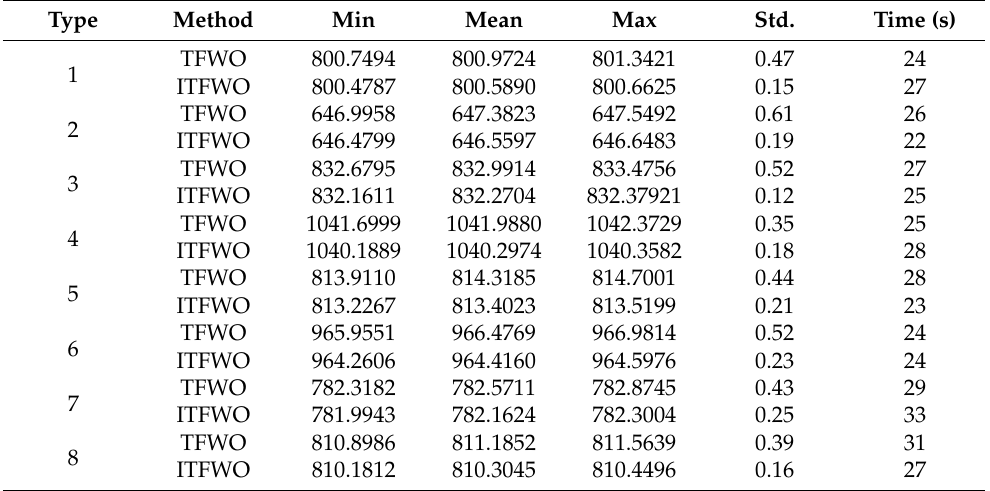
Table 10. The optimal solutions to show the optimization power of the TFWO and ITFWO